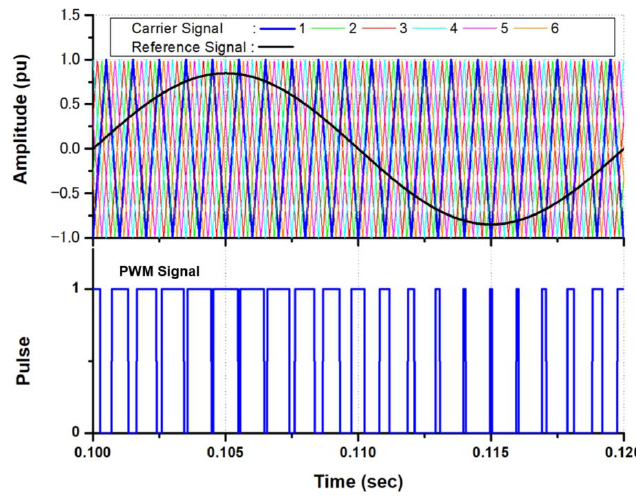
Figure 11. PS-PWM Technique.